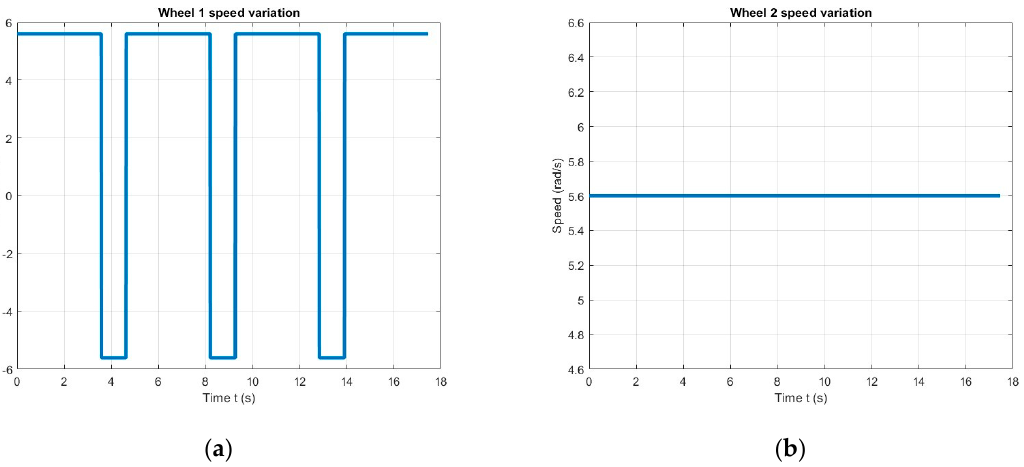
Figure 28. Variations in the input speeds in the dynamic model of the wheels. ( a ) For wheel 1 (similar to wheel 3). ( b ) For wheel 2 (similar to wheel 4).